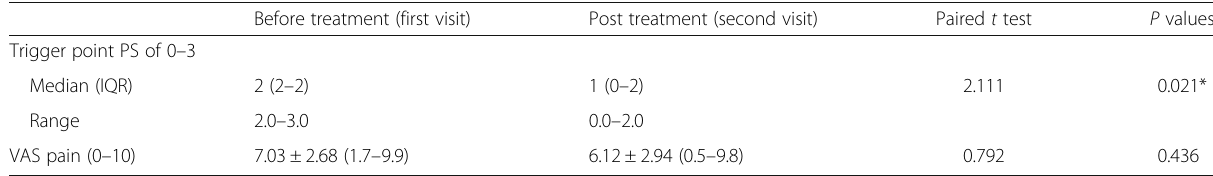
Table 3 Before and after treatment values in the dry needling group. Values are PS pain score median (IQR) and range and mean ± SD and range for (VAS) visual analog scale Before treatment (first visit)